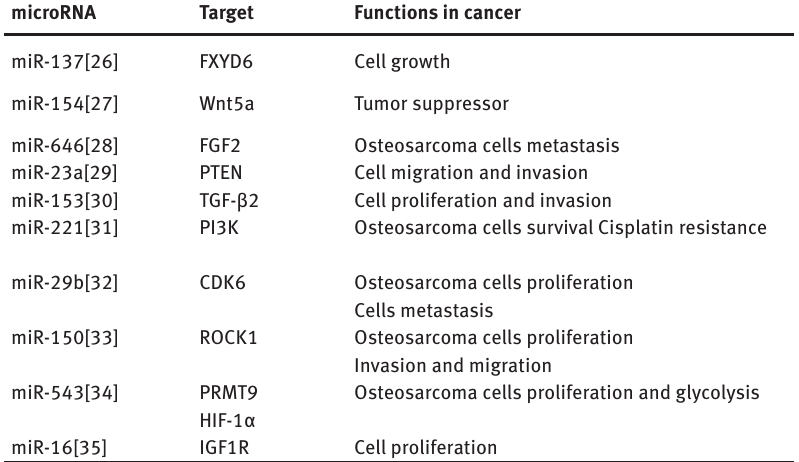
Table 2: Summary of the validated microRNA in preclinical experiments of osteosarcoma.